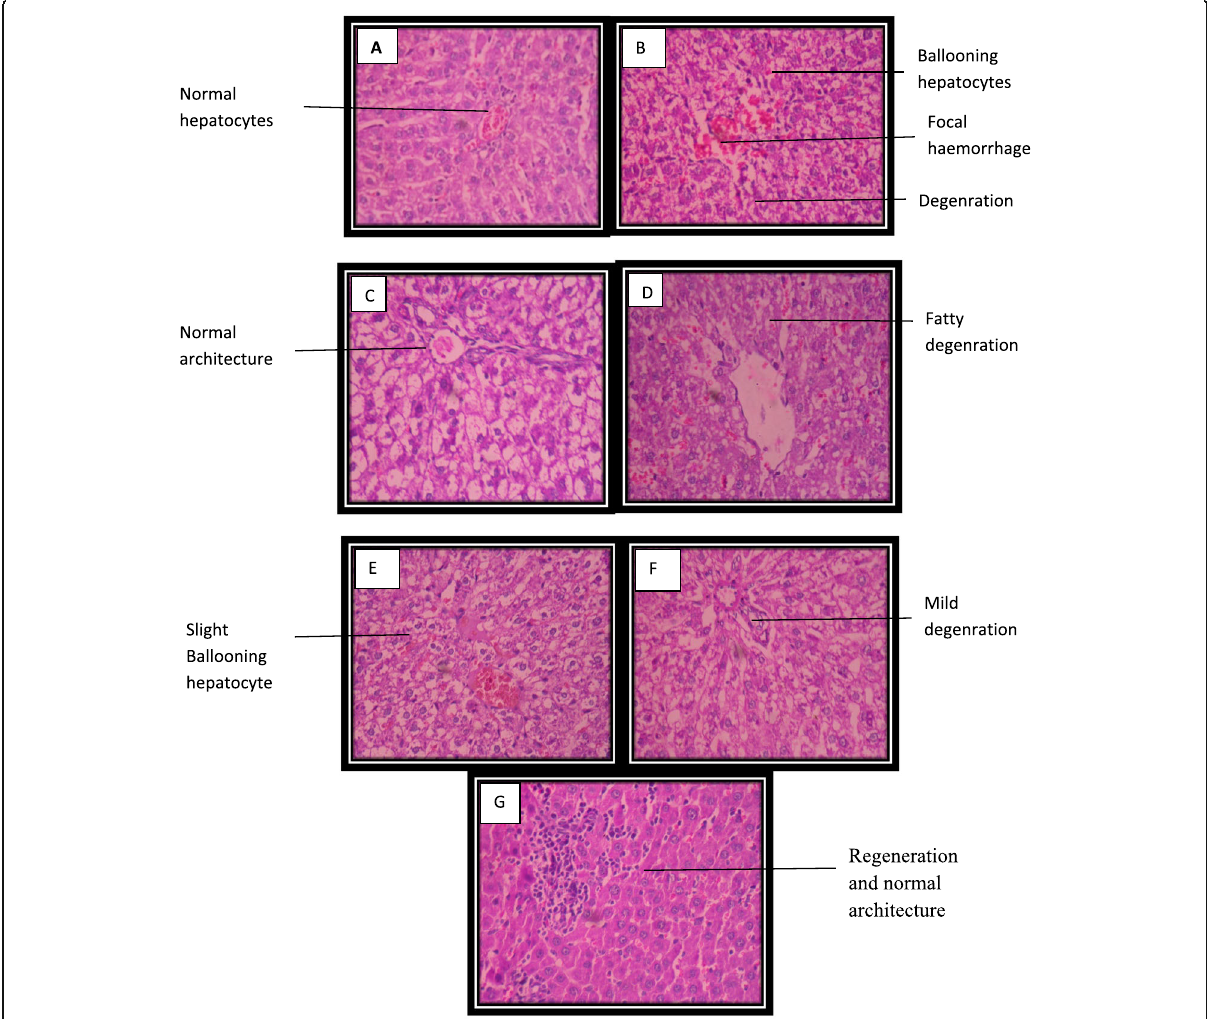
Fig. 7 Effect of PNFC and PNFEA on liver of different groups of